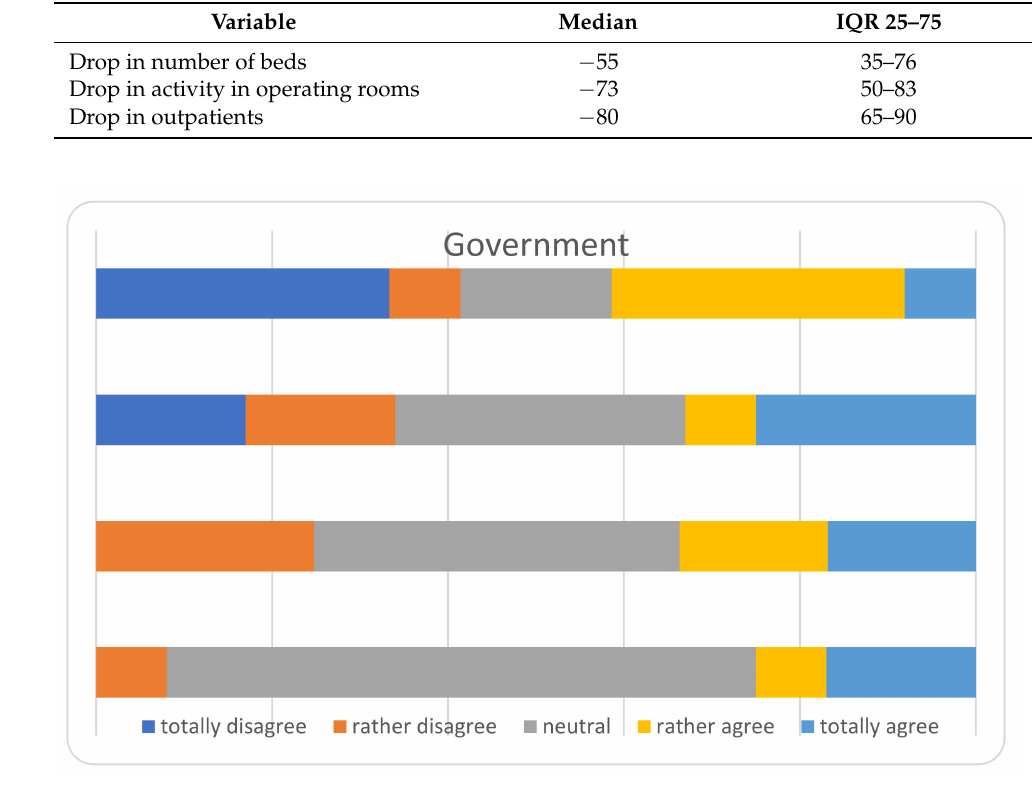
Figure 2. Perceived role of the government.